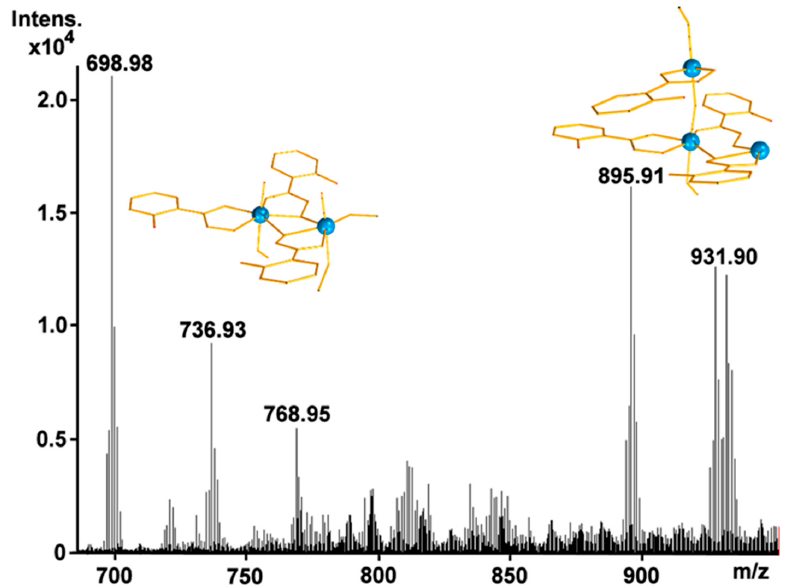
Figure 3. Negative mode of the low m / z region electrospray ionization mass spectrum (ESI-MS) of the {Ti 4 } ( 1 ) cluster in CH 3 OH.